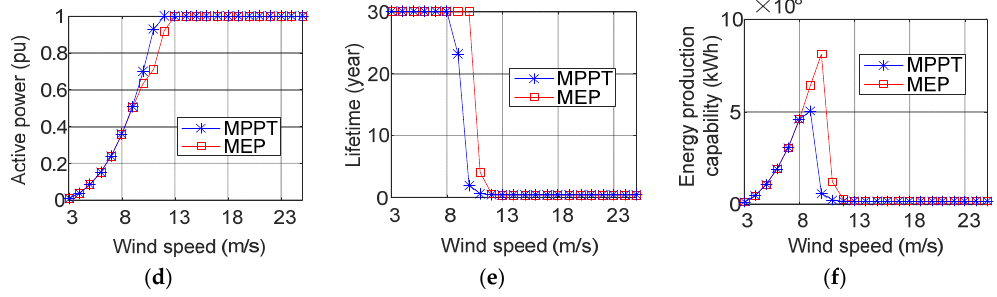
Figure 16. At constant wind direction of 270° and constant wind speed across the whole year, comparison between the MPPT method and the MPG method of: ( a ) pitch angle; ( b ) tip speed ratio; ( c ) rotor speed; ( d ) active power; ( e ) lifetime; ( f ) energy production capability of WT 2 .